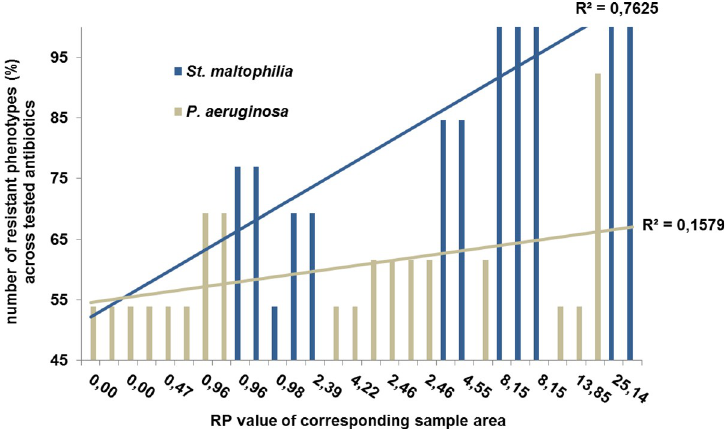
Fig 6. Phenotypic resistance of St. maltophilia and P. aeruginosa isolates in relation to increasing intI1 prevalence (RP) of the sample area.